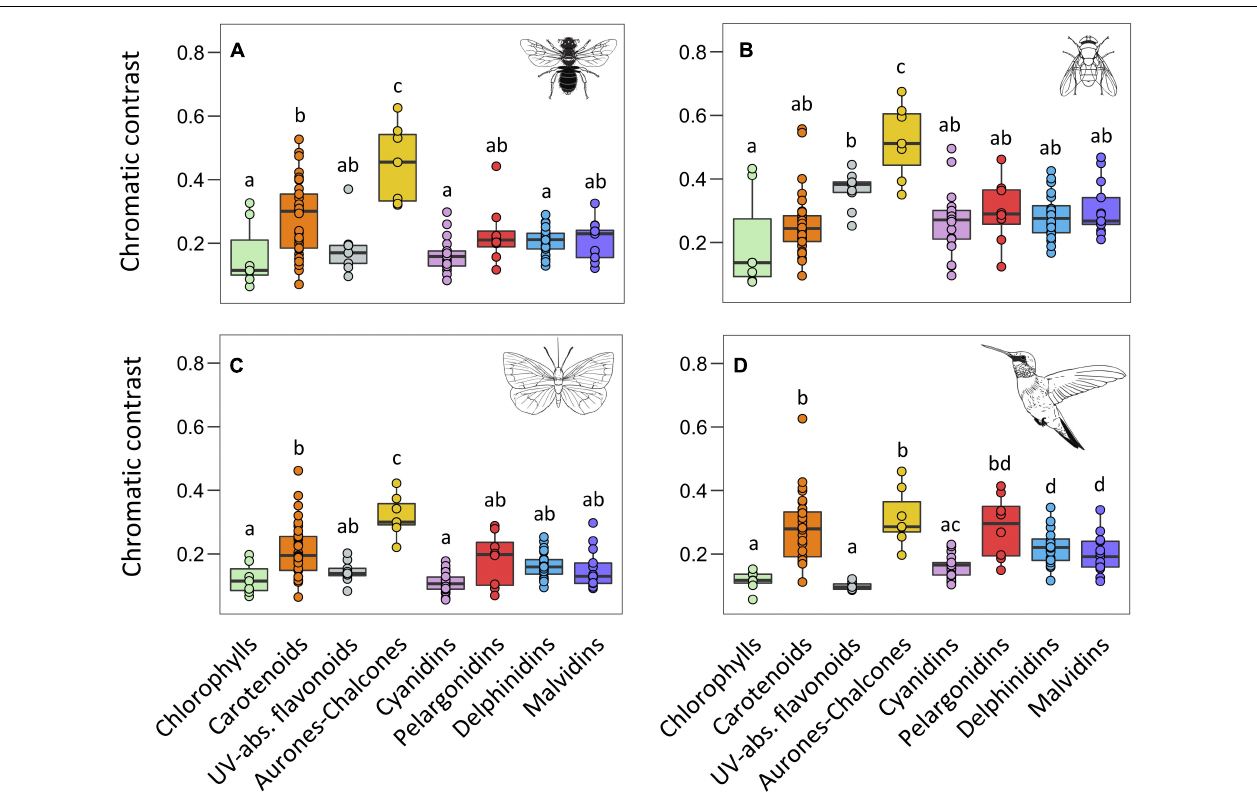
FIGURE 3 | Boxplots representing the distribution of chromatic contrast values for each type of pigment obtained from the vision models of bees (A) , flies (B) , butterflies (C) , and birds (D) . The central line displays the median, the bottom and top of the box are the first and third quartiles, and dots represent sample values. We performed phylANOVAs with 10,000 simulations and Holm-adjusted P -value. Different letters represent significant differences at 0.05 level. Animal silhouettes taken from Divulgare (www.divulgare.net) under a Creative Common